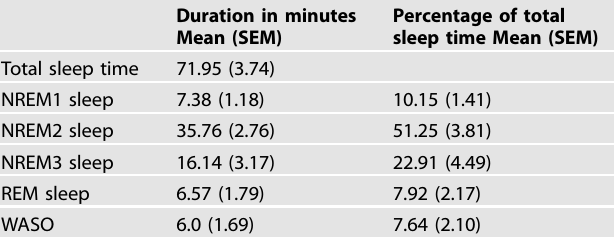
Table 1. Descriptive sleep measures of the nap